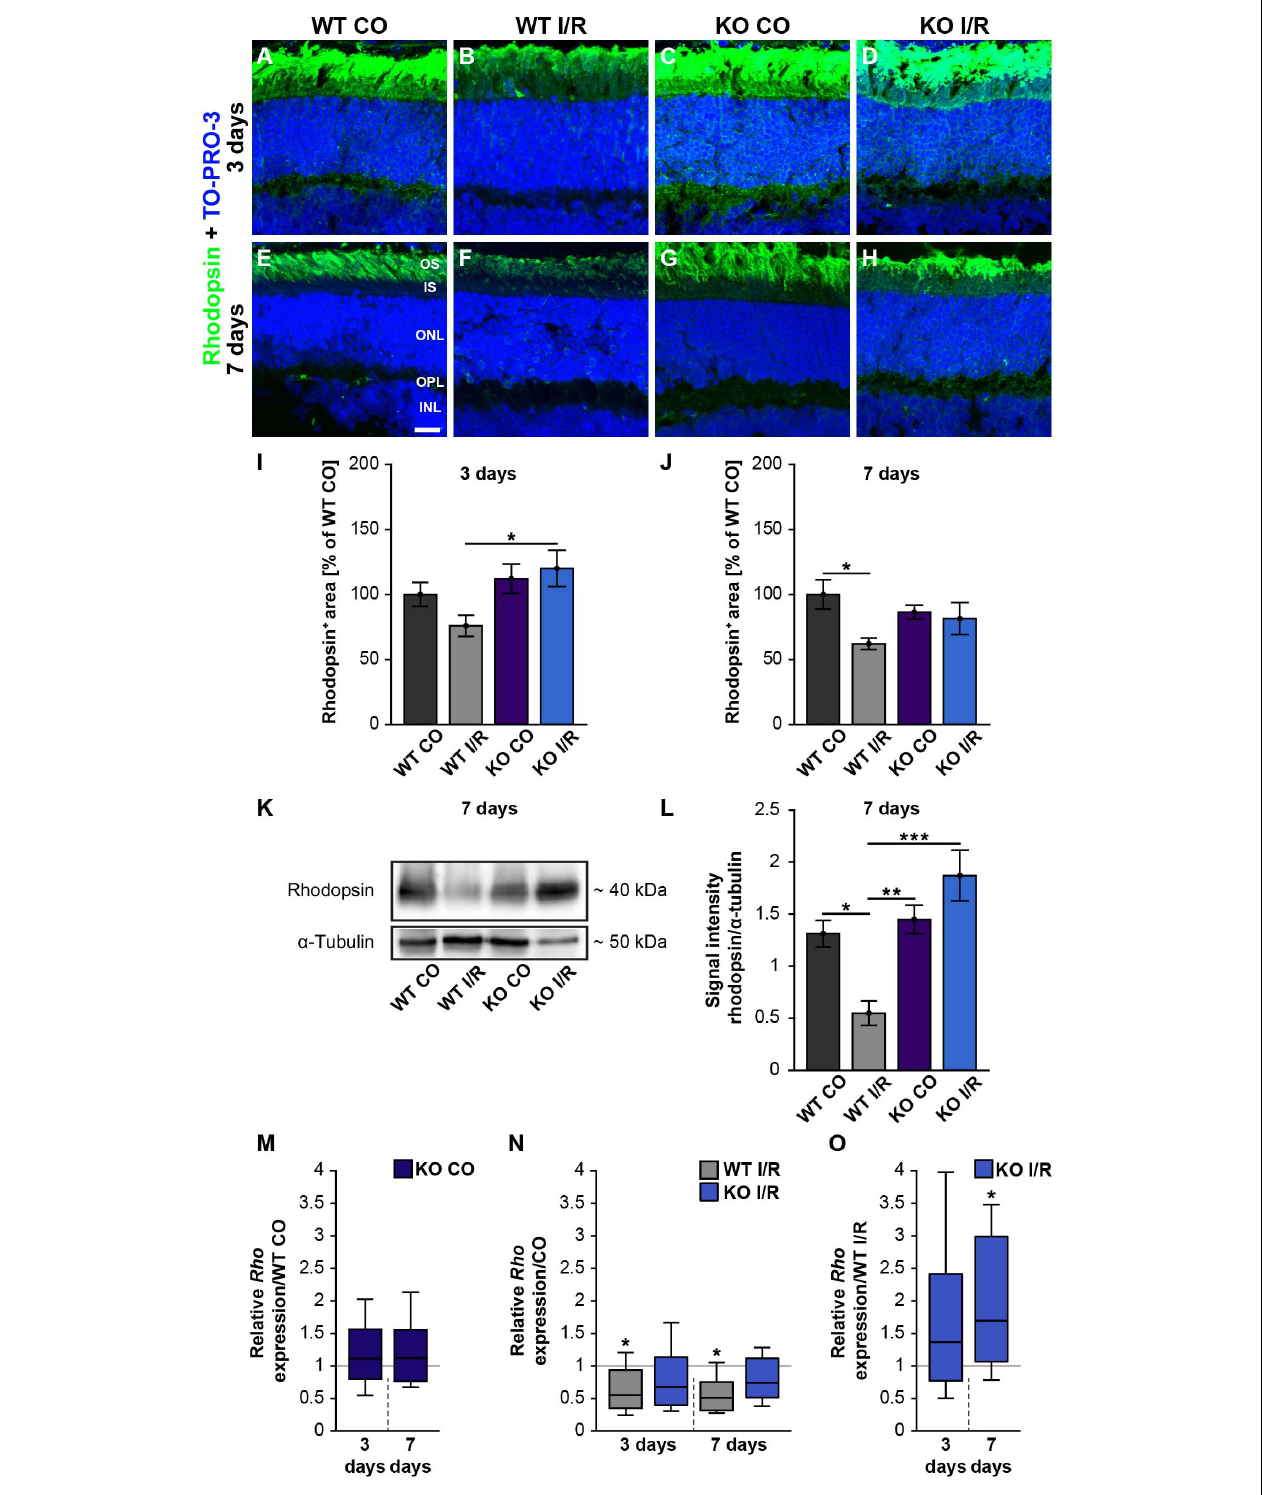
FIGURE 6 | Preservation of rod-photoreceptor cells in the ischemic Tnc KO retina. (A–H) Rod-photoreceptors were labeled with rhodopsin (green) in control and ischemic WT and KO retinae 3 and 7 days after I/R. TO-PRO-3 (blue) was used as nuclear counterstain. (I) At 3 days, a significantly decreased rhodopsin staining area was only noted in the ischemic WT group, but not in the ischemic KO group. Moreover, the rhodopsin staining was significantly increased in the KO I/R group